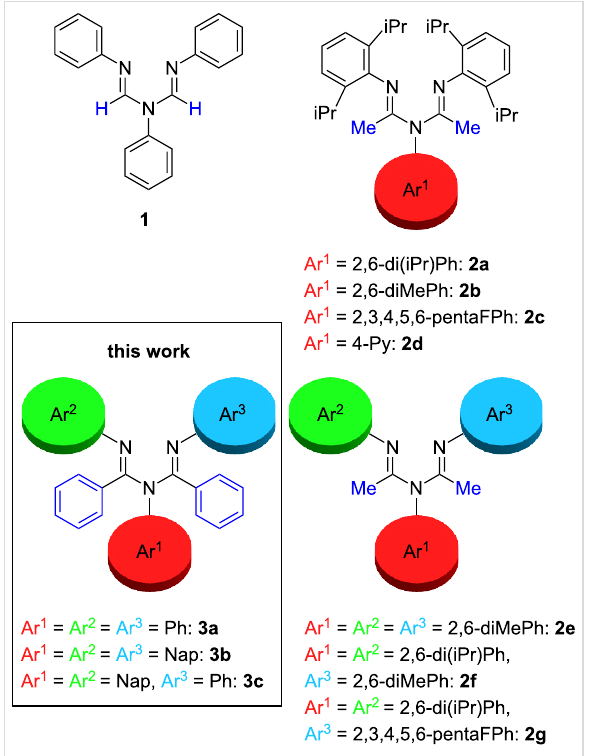
Figure 1: Sterically crowded, and neutral chelating diimine